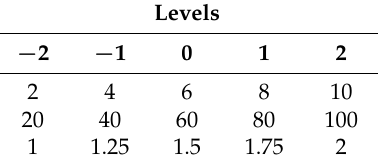
Table 1. The different values for different levels of conductivities ( µ S/cm), viscosities (mPa · s), and nozzle-to-substrate distances (mm).